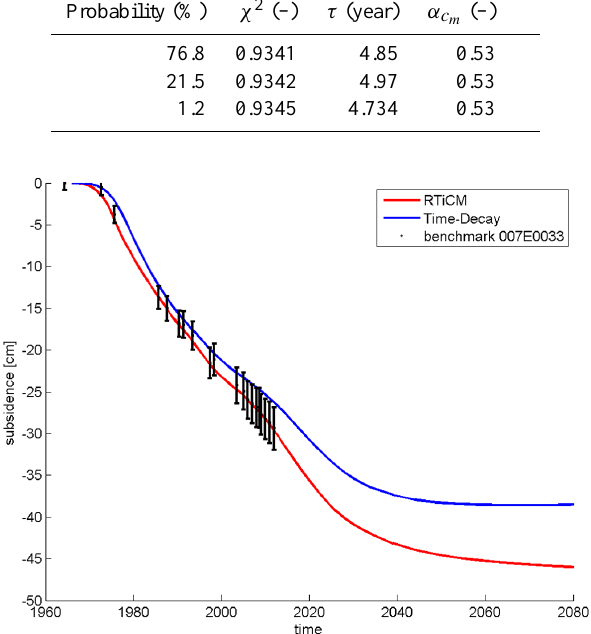
Figure 3. Different compaction models (RTiCM, linear isotach and Time Decay) and their fit to a levelling benchmark in the center of the field (from: TNO,